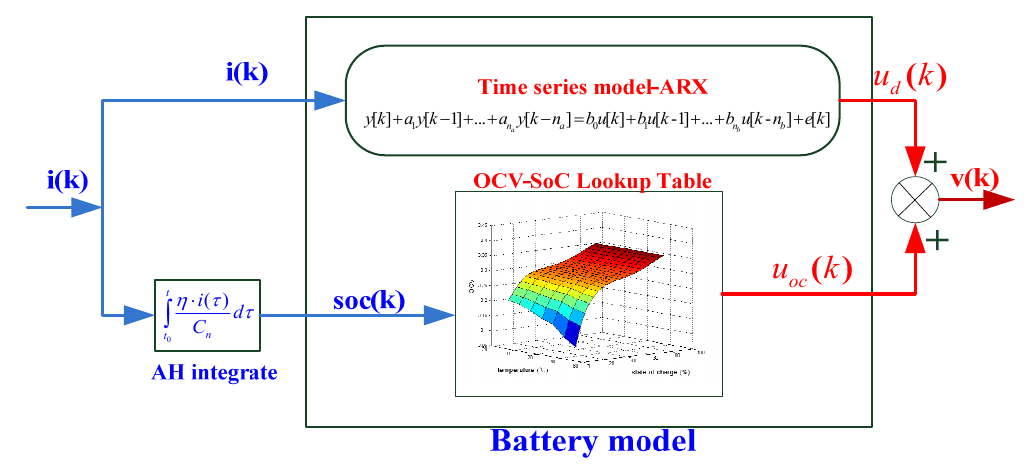
Figure 8. The detail diagram of the ARX battery